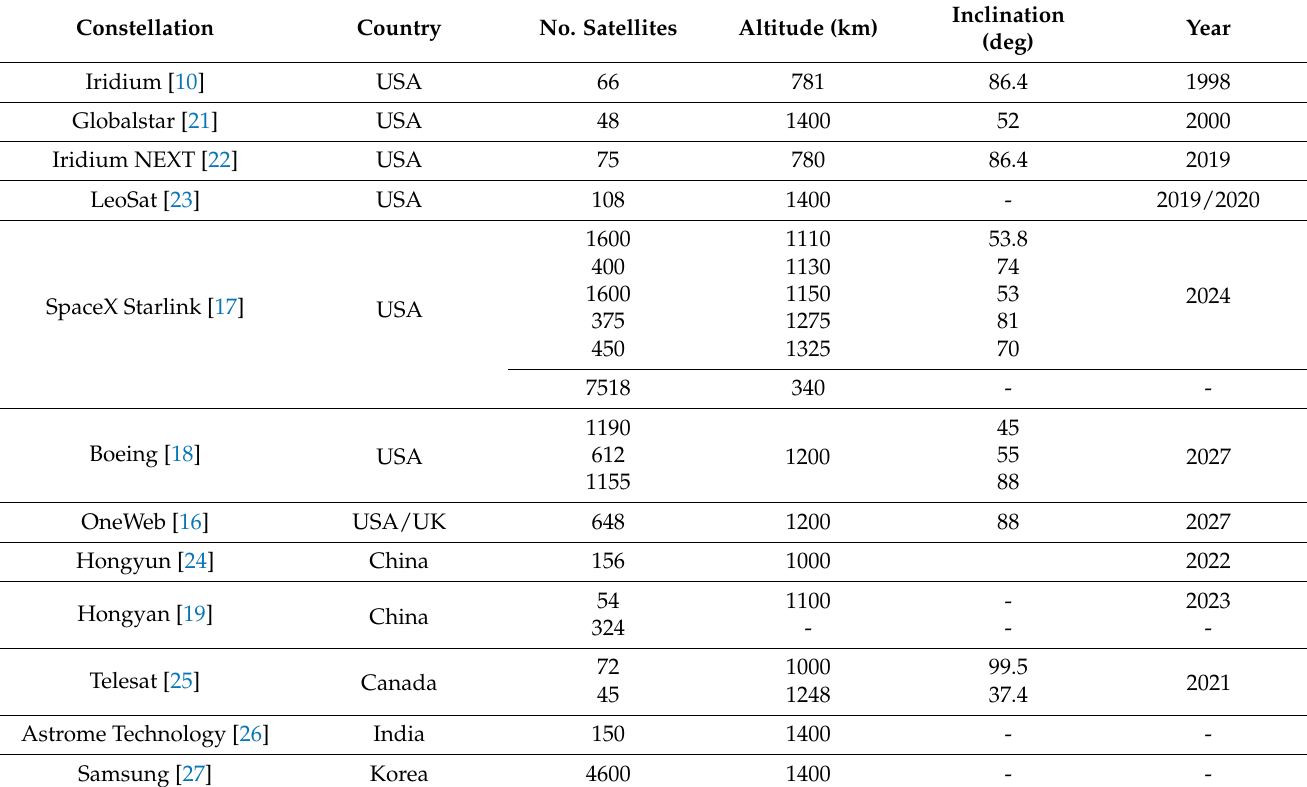
Table 1. Summary of some commercial LEO